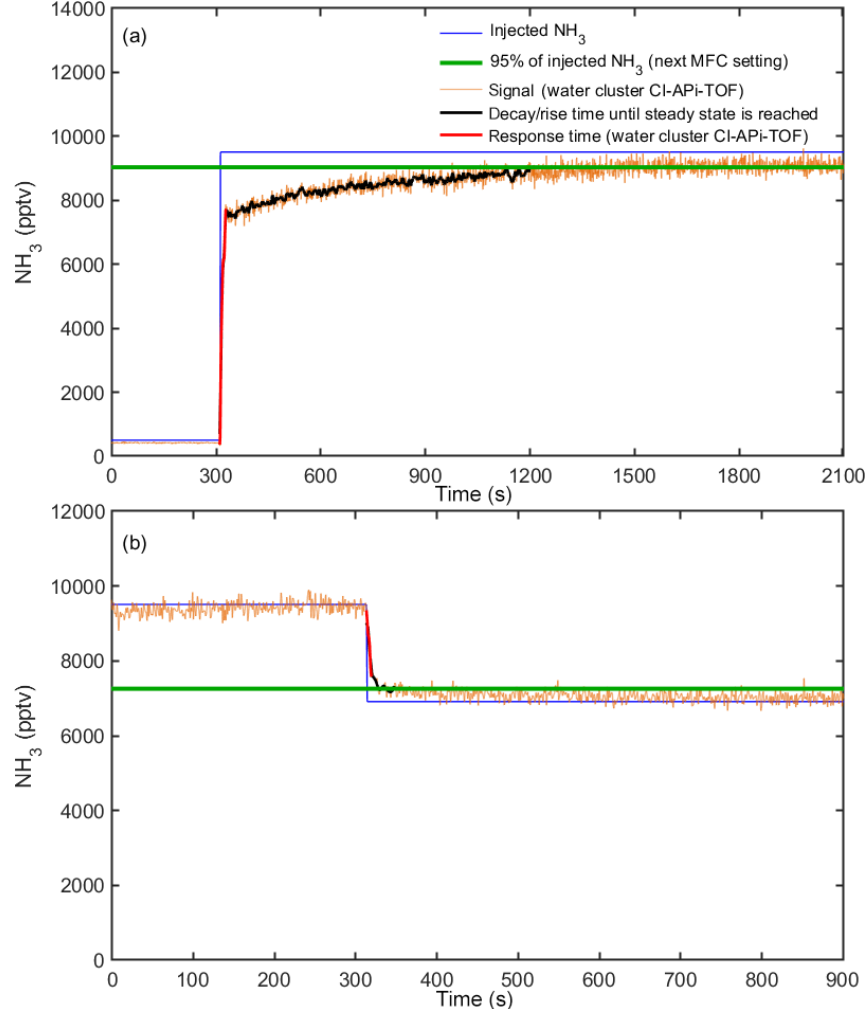
Figure 4. Response time of the water cluster CI-APi-TOF during calibrations at 60% RH. The injected ammonia mixing ratio from MFC settings is shown by the blue line. The signal of the water cluster CI-APi-TOF is shown by the orange line (here the data are shown with a 1s time resolution; i.e., no time averaging is applied). The green line represents 95% of the mixing ratio being applied with the next MFC setting. The black line shows the response time until a steady state (a) or 95% of the final measured concentration is reached (b) . The response time is the sum of the response time of the water cluster CI-APi-TOF (red line) and the (slower) response time for the lines to reach a steady state at which the walls are